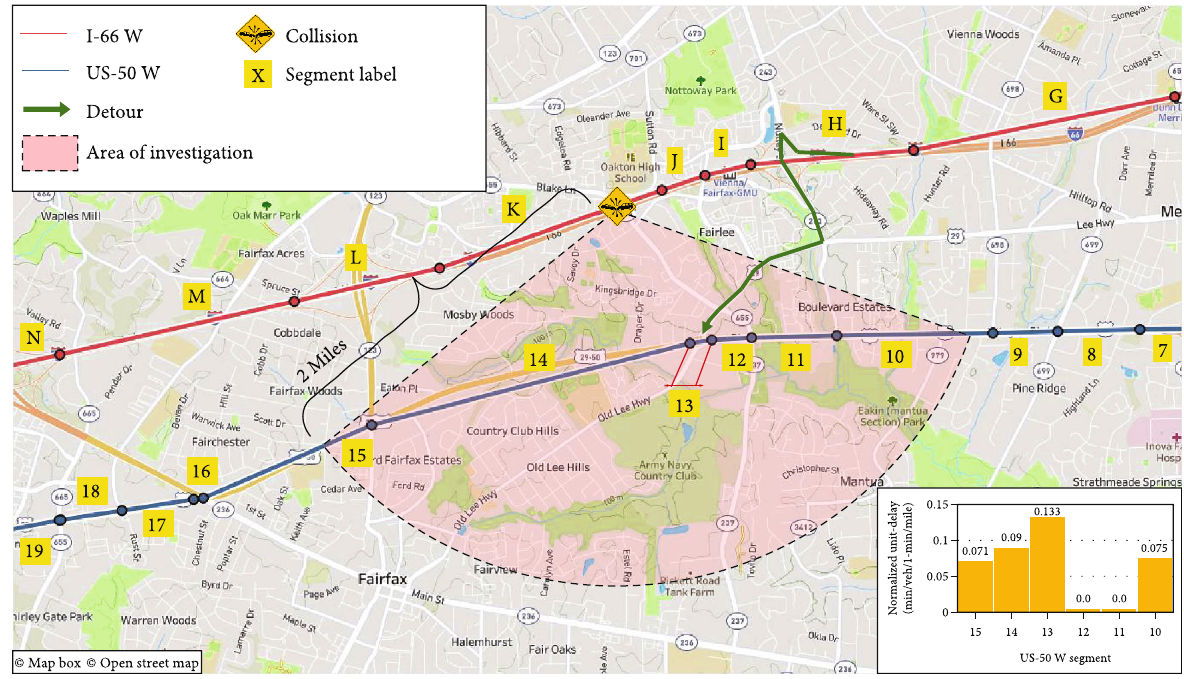
Figure 10: The area of investigation of a 2-mile radius, at which the potentially impacted segments of US-50 W are selected.